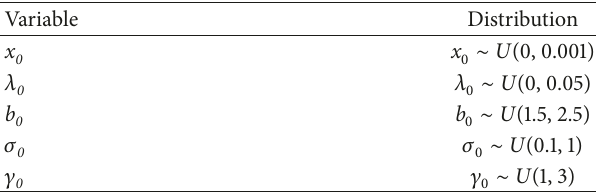
Table 3: Prior distribution of the